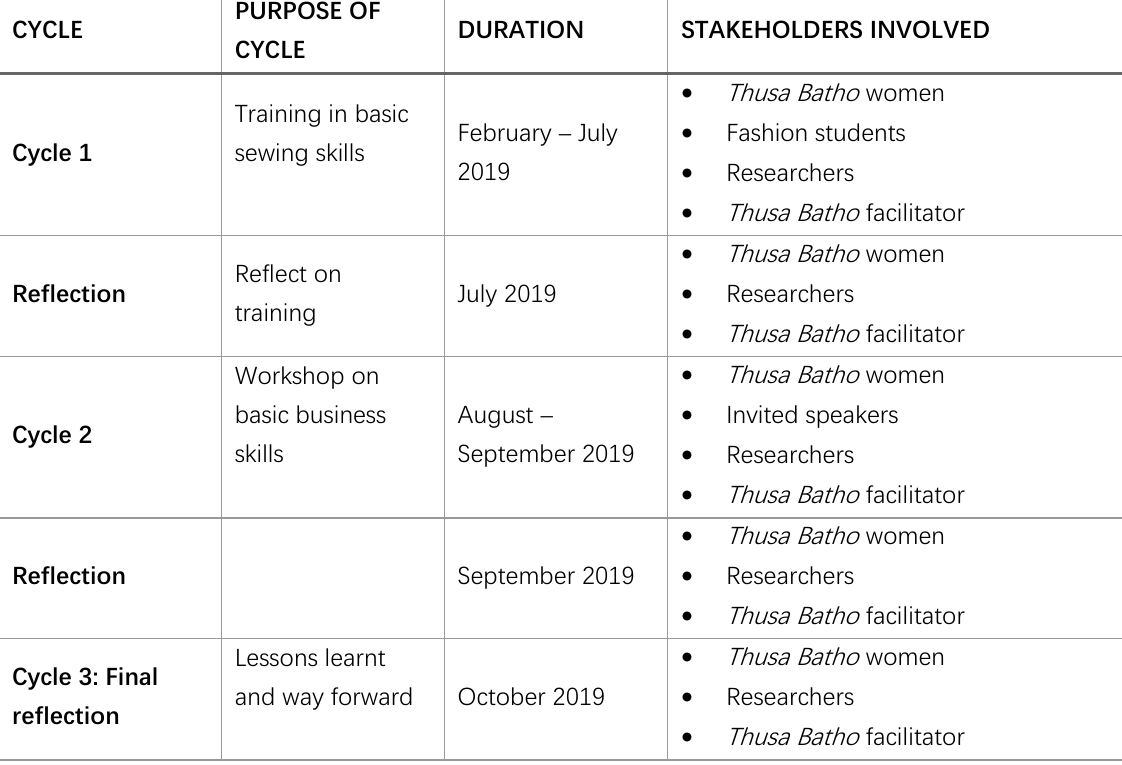
Table 1 : The iterative cycles with their purposes, duration and people involved